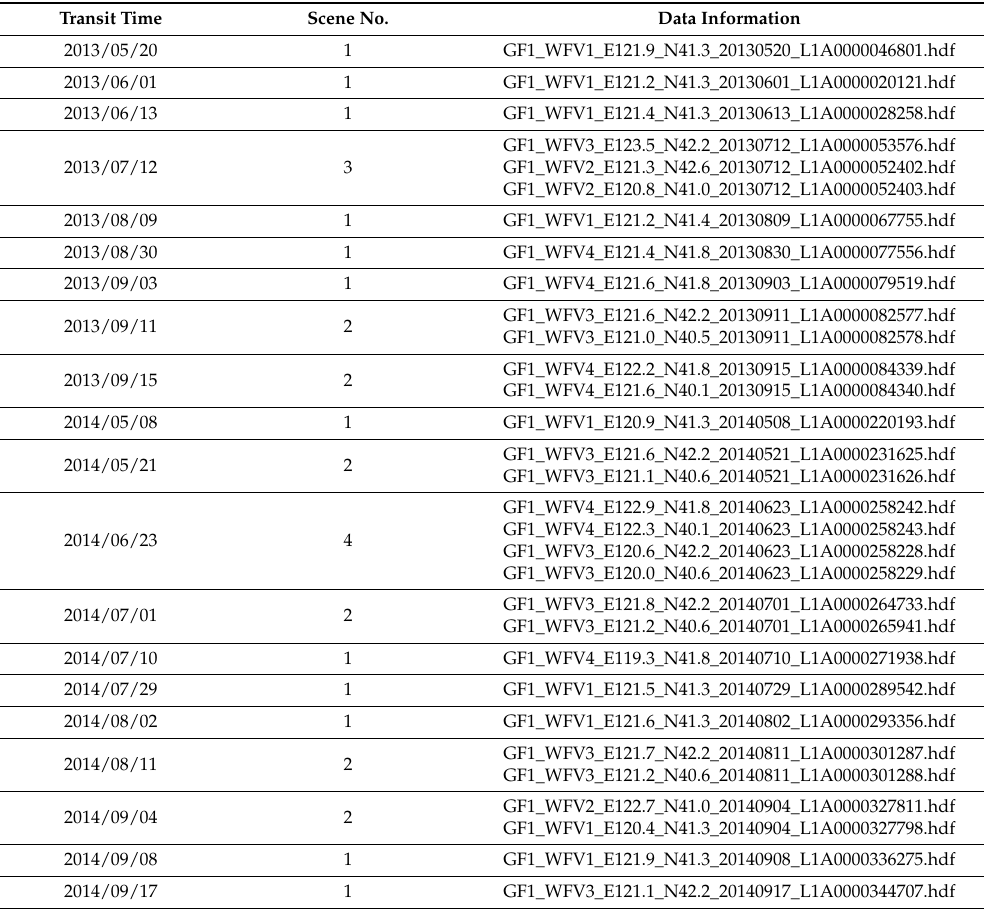
Table 2. Used GF-1 WFV data